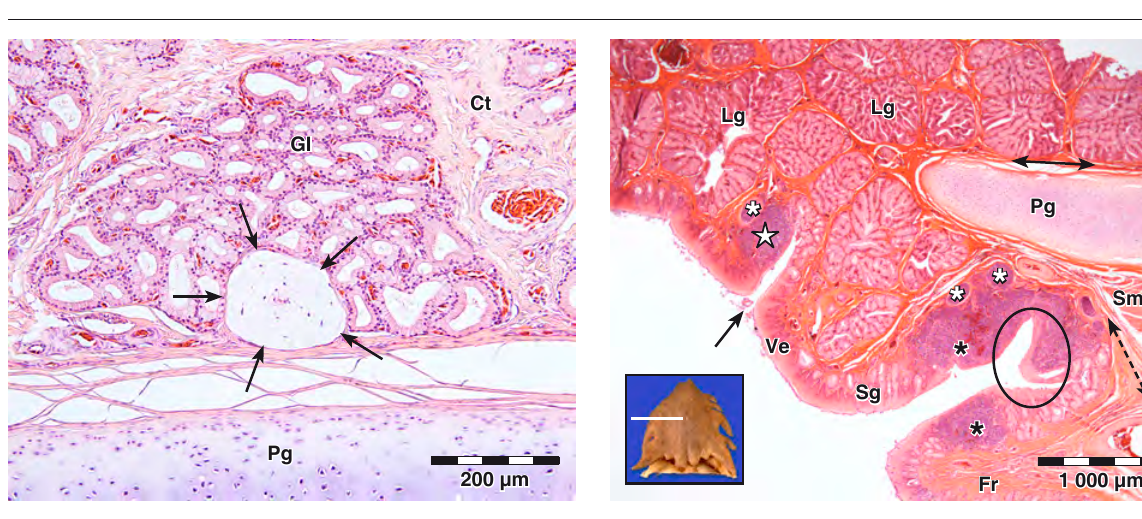
FIG. 7 Dorsum of the tongue showing a Herbst corpuscle (ar­ rows) deeply positioned adjacent to the paraglossum (Pg). The corpuscle appears in cross­section and is closely associated with a large, simple branched tubu­ lar gland (Gl). Connective tissue (Ct)